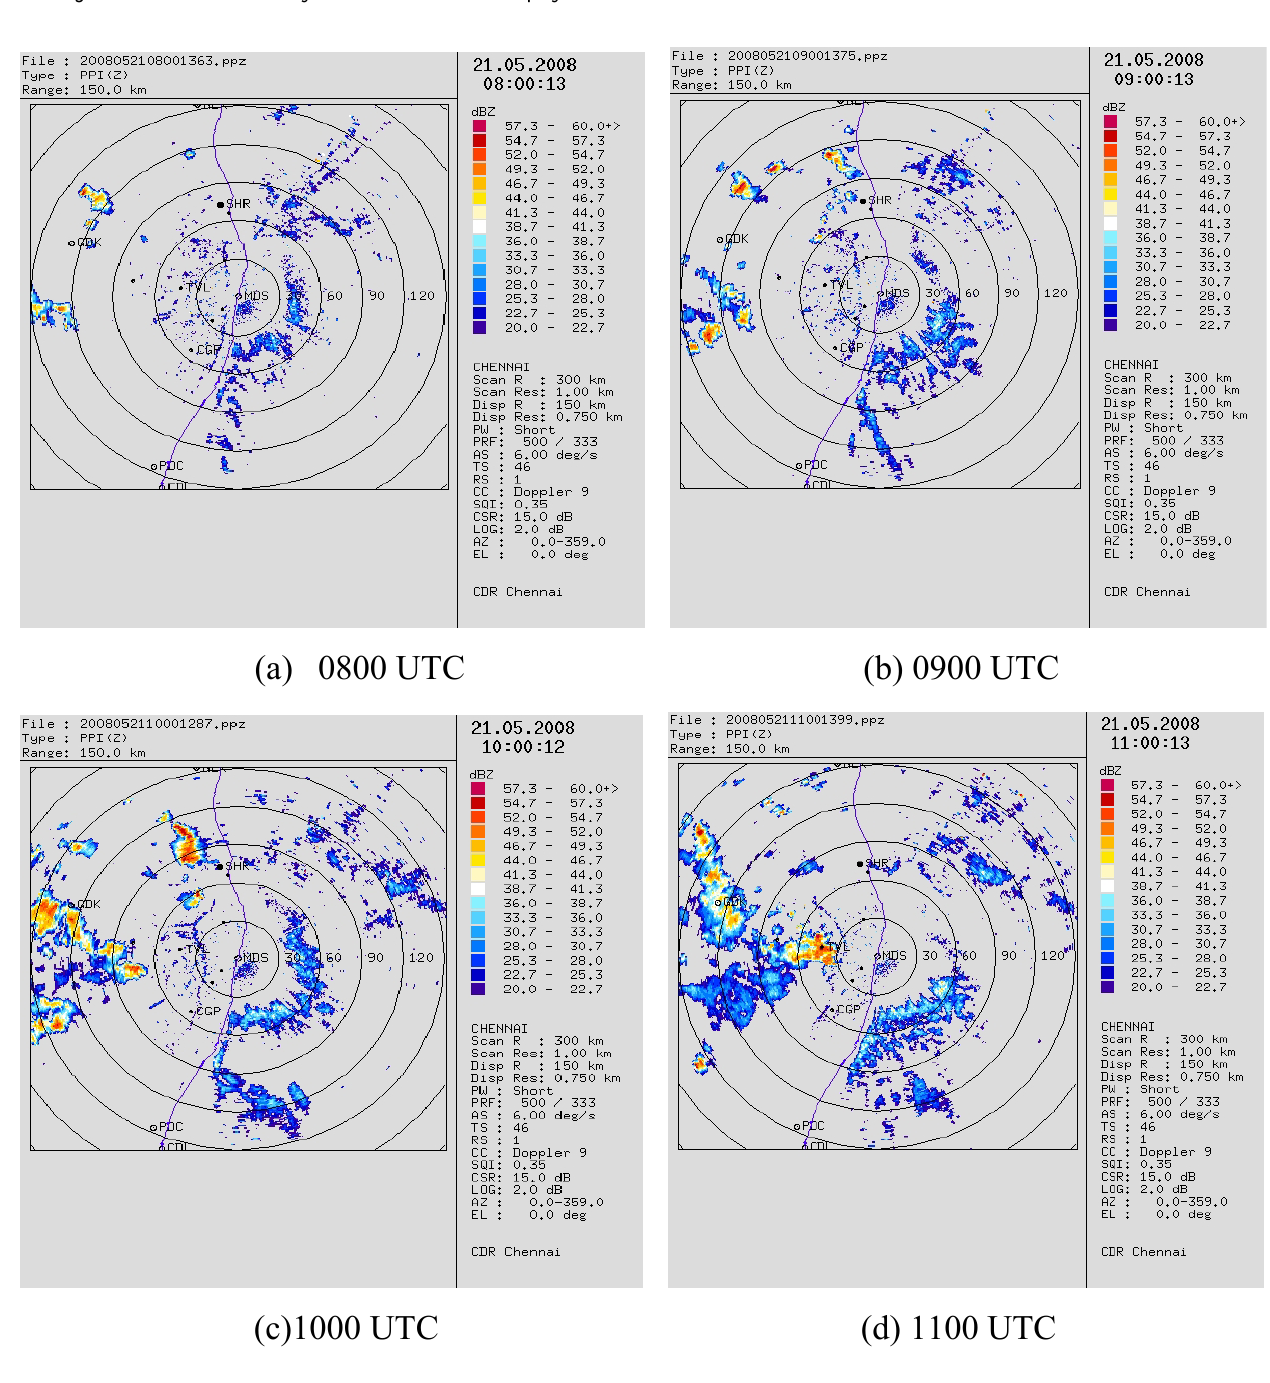
Fig. 2. Spatial distribution of maximum reflectivity observed by the DWR at Chennai at (a) 08:00UTC, (b) 09:00UTC, (c) 10:00UTC, and (d)